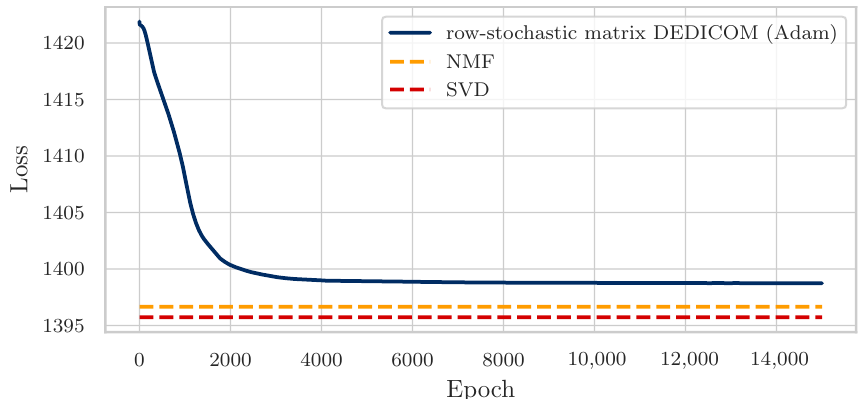
Figure 4. Reconstruction loss development during matrix factorization training. The x -axis plots the number of epochs, the y -axis plots the corresponding reconstruction error for each